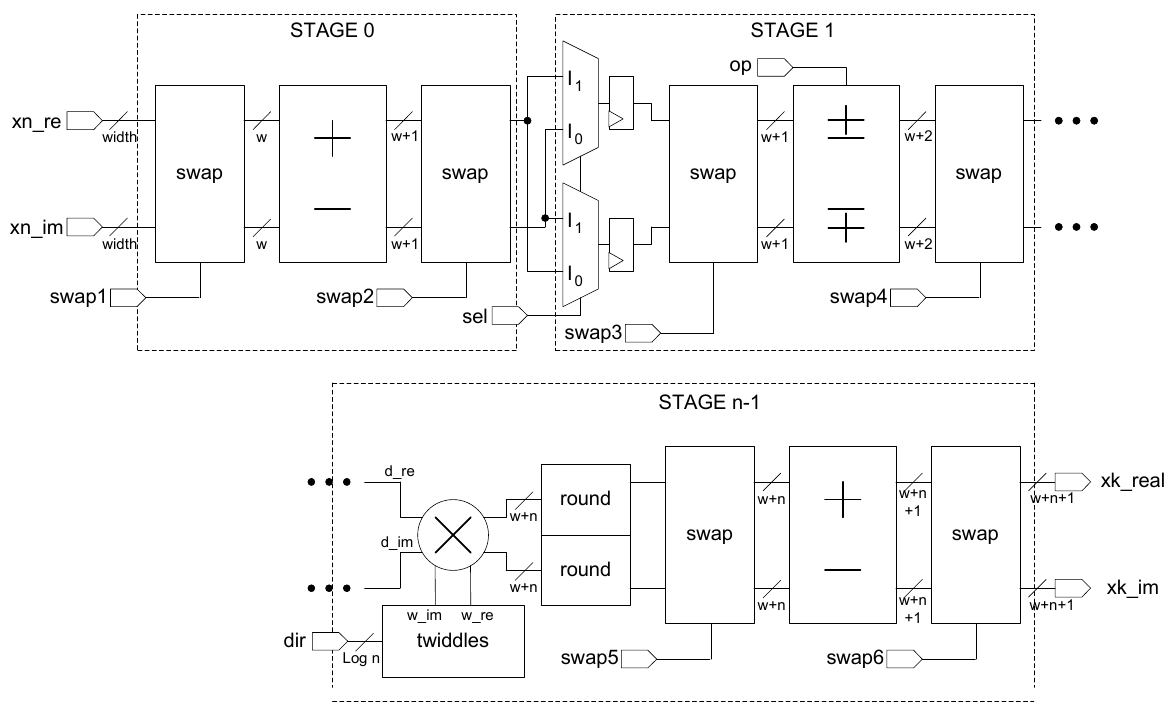
Figure 6. Architectural block diagram of a pipeline radix-2